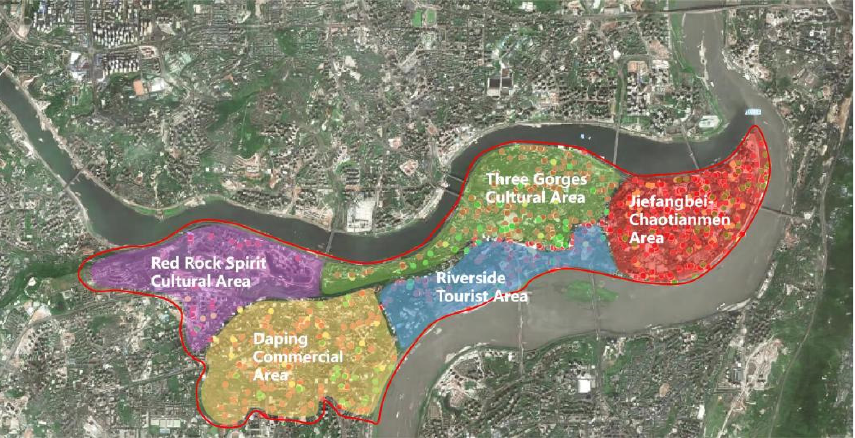
Figure 5. Diagram of the functional zoning of Yuzhong District, Chongqing.